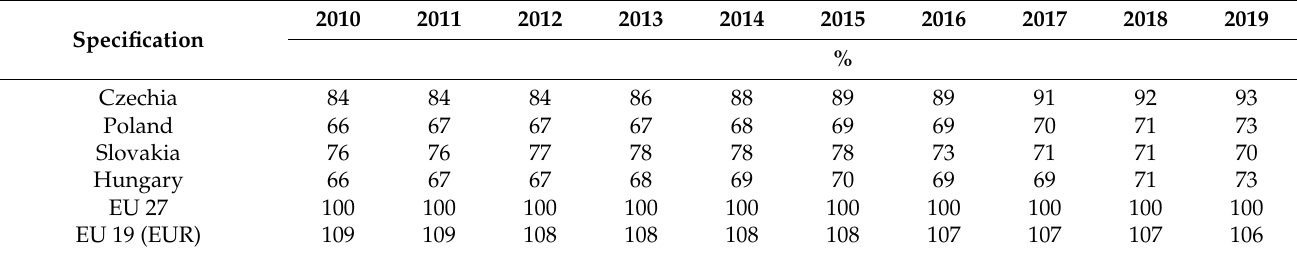
Table 3. Index of GDP per capita by purchasing power parity in the Visegrad Group countries [37]. Specification